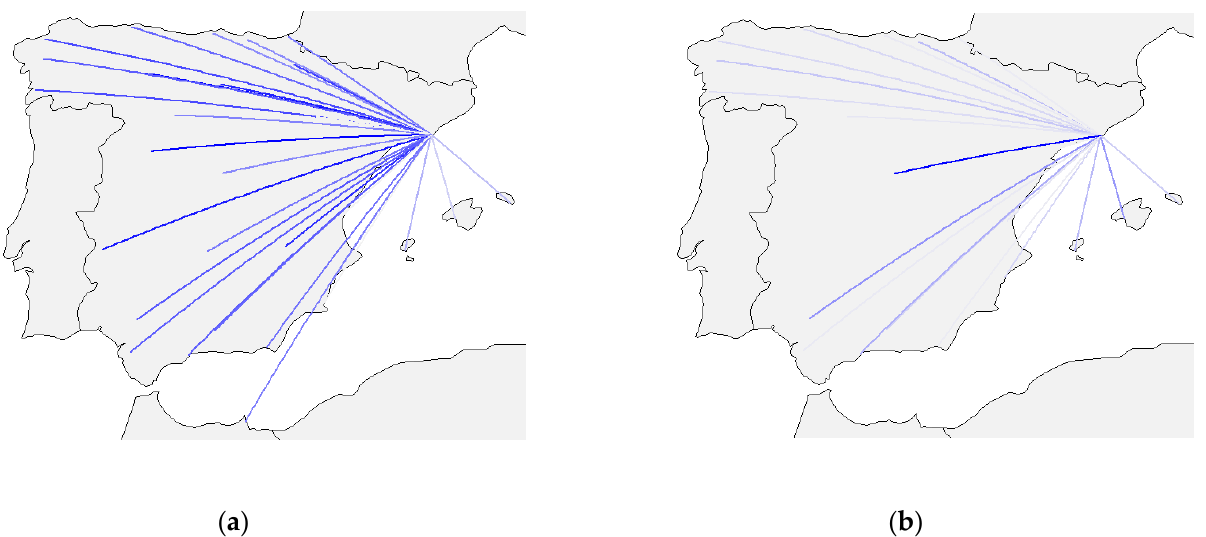
Figure 9. Carbon dioxide emissions from main domestic corridors operating in BCN airport, where a rough sketch means more emissions than the thinner one as follows: ( a ) Partial emission per passenger and route (arithmetic average: 79.39, standard deviation: 25.64); ( b ) Total emission of routes concerned. Source: own elaboration from the data provided by [19,20].